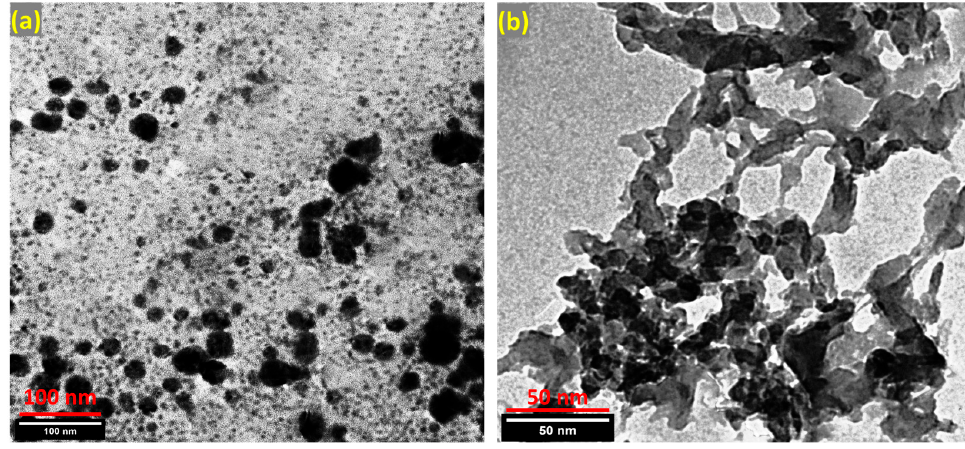
Figure 3. ( a , b ) TEM images of the green synthesized MgFe 2 O 4 NPs and MgFe 2 O 4 @CaAlg NCs, re- spectively.